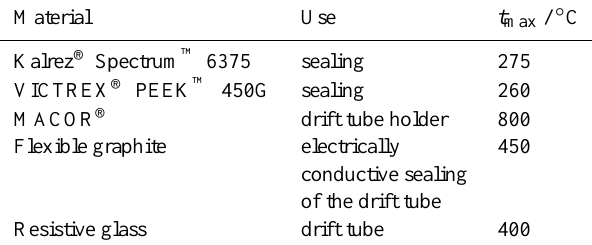
Table 1. Materials used in the HT-PTR-MS and their maximum continuous operation temperatures ( t max